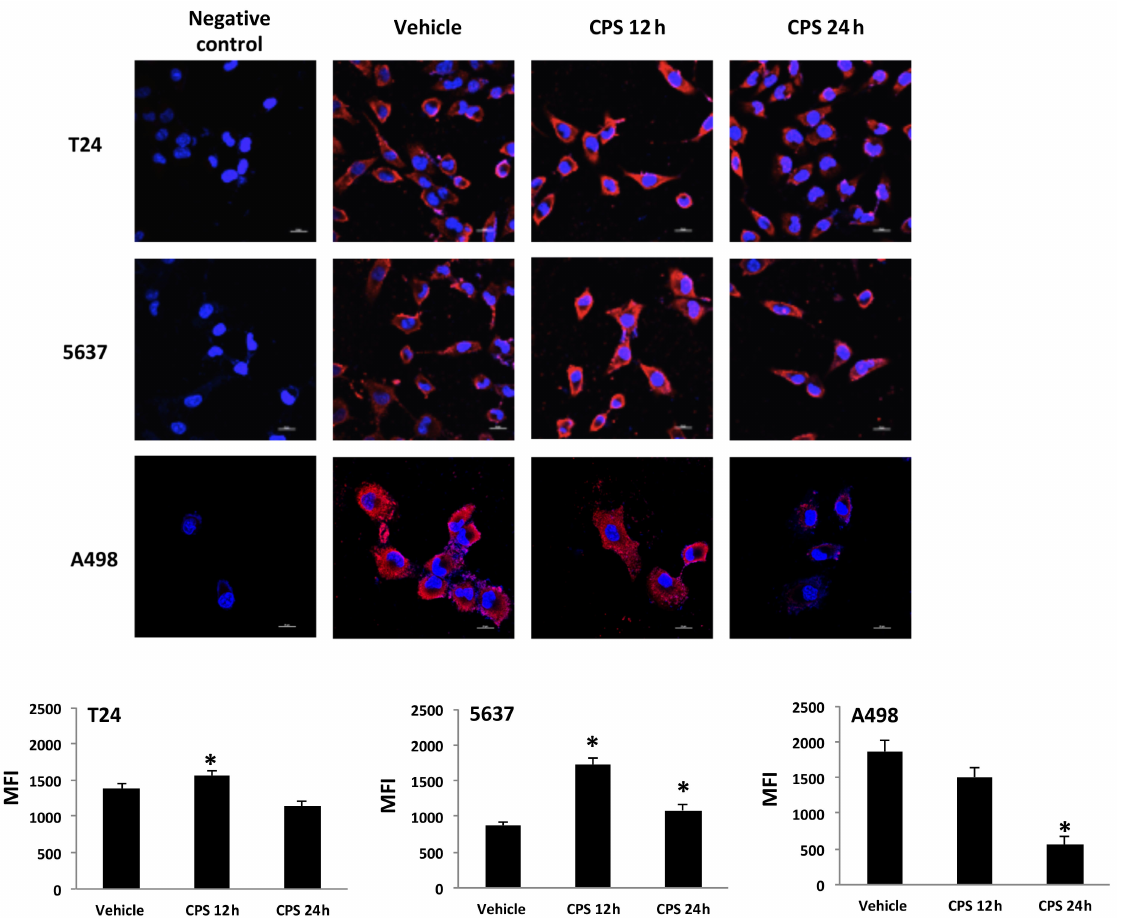
Figure 3. PD-L1 localization in CPS-treated cells. Confocal microscopy analysis of PD-L1 expression in T24, 5637 and A498 cells treated with CPS. Cells were stained with anti-human PD-L1 followed by Alexa Fluor-594 secondary Ab. We used 40,6-diamidino-2-phenylindole (DAPI) to counterstain nuclei. MFI = mean fluorescence intensity. Data are expressed as mean ± SEM; * p < 0.01 vs. vehicle-treated